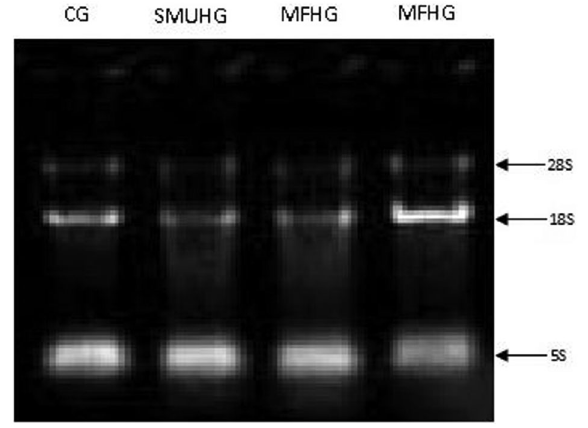
Figure 13. Results of RNA electrophoresis of SMMC-7721 cells in 3 groups. CG: control group A (RPMI 1640 culture medium only); SMUHG: spiking group (8 g/L Fe 2 O 3 , no radiation); MFHG: magnetic fluid hyperthermia group ( lane 3 : 2 g/L Fe 2 O 3 ; lane 4 : 8 g/L Fe 2 O 3 ).